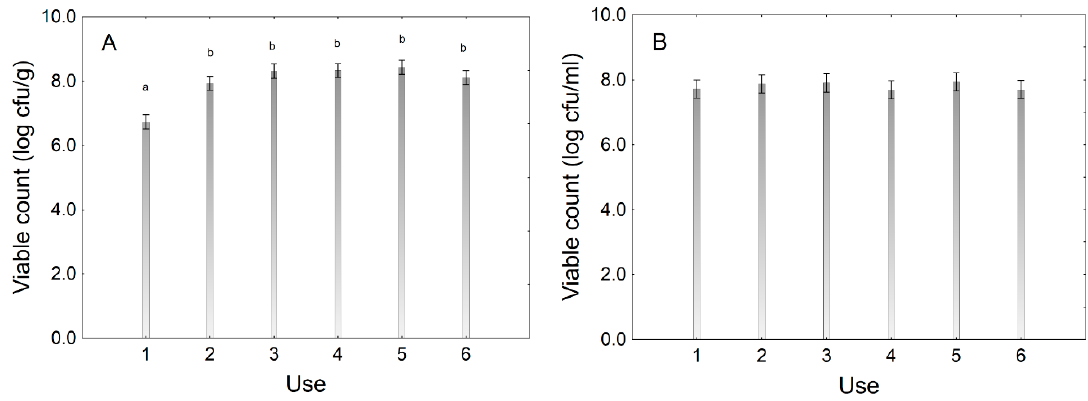
Figure 3. Results for experiment B (apple pieces stored at 4 °C for 7 days before their use). Viable count of S. cerevisiae W13 on apple pieces as a function of the number of uses ( A ) and after 24 h of fermentation in cider ( B ). Bars denote 95% confidence intervals. In ( A ), letters indicate significant di ff erences (one-way ANOVA and Tukey’s test, p < 0.05), while in ( B ), the samples were not significantly di ff erent ( p > 0.05). Free, free cells